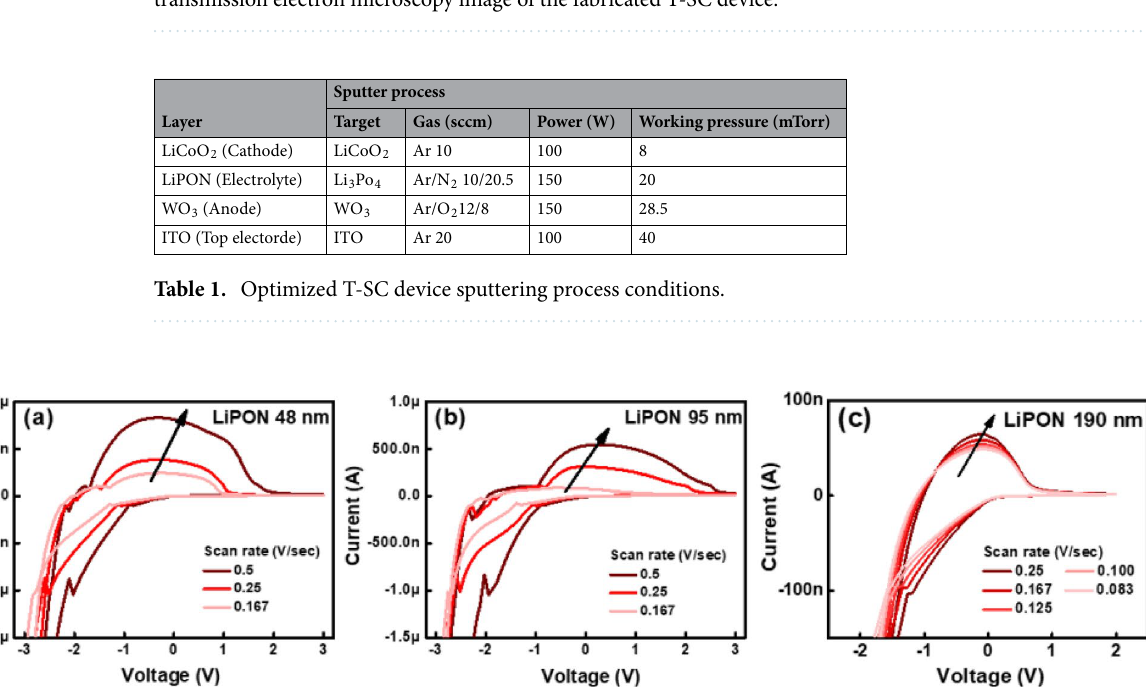
Figure 1. ( a ) Schematics of the developed Glass/ITO/LiCoO 2 /WO 3 /ITO T-SC device. ( b ) Cross-sectional transmission electron microscopy image of the fabricated T-SC device.